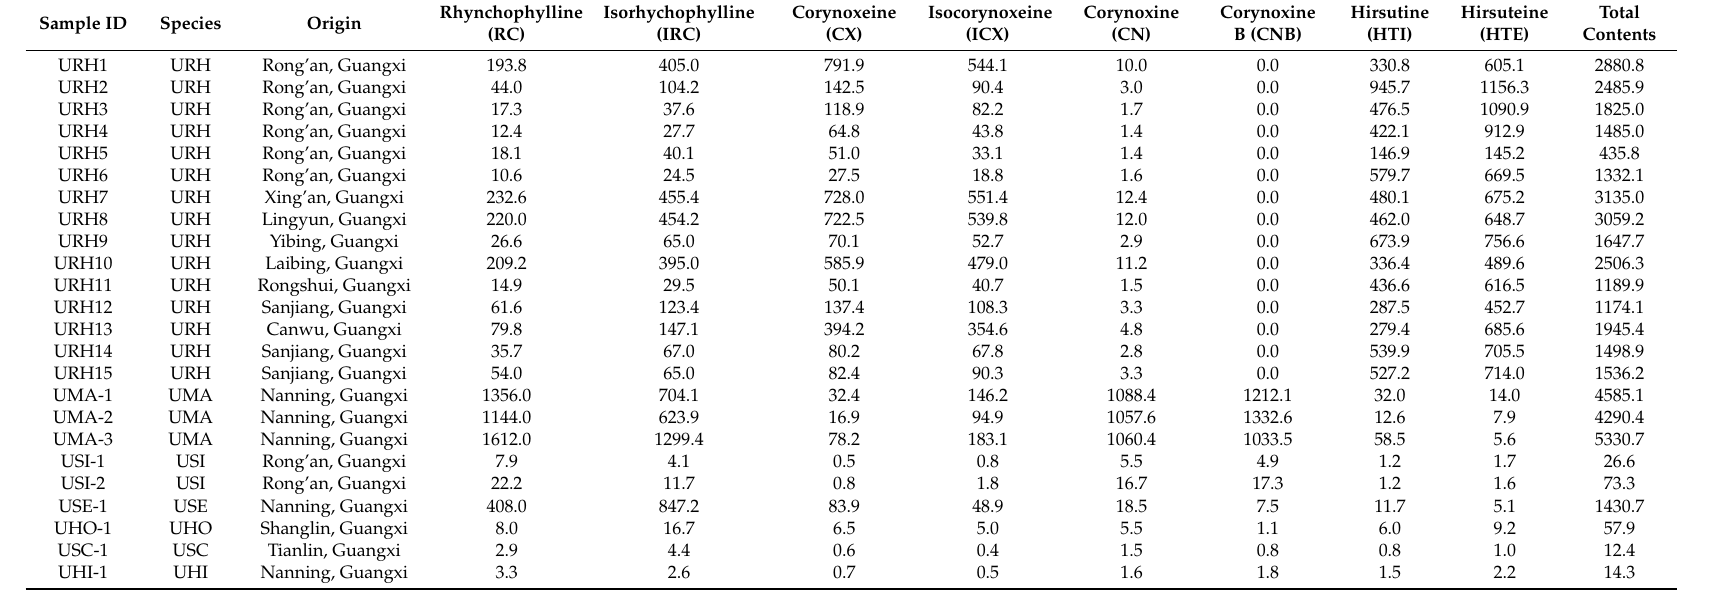
Table 2. Content (mg/g) of eight targeted alkaloids in materials of Uncaria species from Guangxi